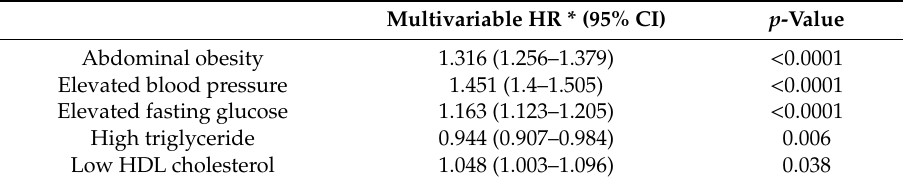
Table 4. Risk of atrial fibrillation according to individual components of metabolic